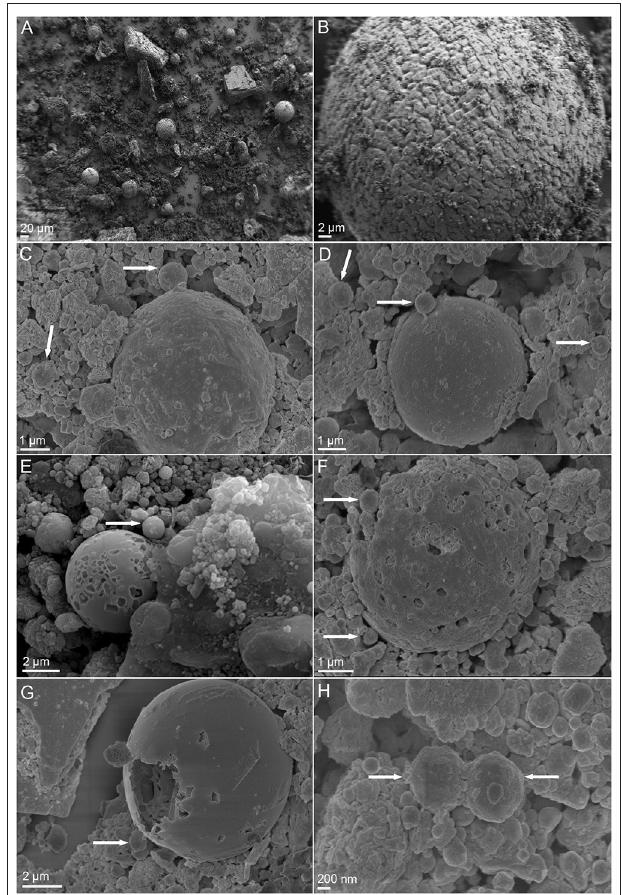
FIGURE 4 | Scanning electron microscopy (SEM) images of BOF-dust particles and cells of A. manzaensis . (A) Overview of raw, unprocessed dust sample; (B) Enlarged image of unprocessed dust corn particle; (C,D) Microbially processed sample, shown are dust corn particles with co-localized A. manzaensis cells. (E–G) Microbially processed sample, shown are dust corn particles with co-localized A. manzaensis cells; (H) Microbially processed sample, shown are dividing cells of A. manzaensis . White arrows indicate cells ( ∼ 1 µ m size). Microbially processed grains of waste dust product are bigger (up to 5–20 µ m) and are shown in (C–G) , revealing their microbially etched surface.